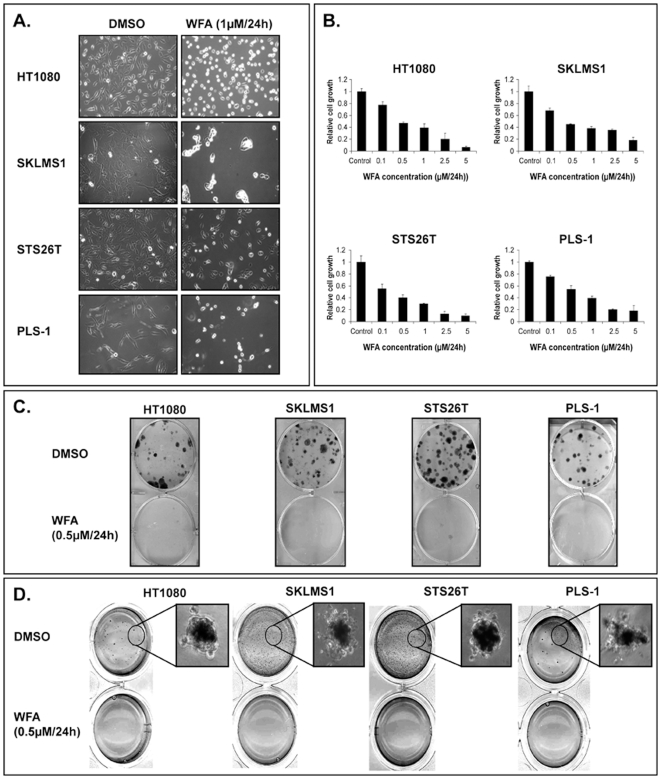
WFA inhibits STS cell growth.
A) WFA treatment (1 µM/24 h) results in marked morphological changes, including cell-rounding and nuclear condensation, in STS cells; B) MTS assays demonstrate a WFA-induced, dose-dependent decrease in STS cell growth; C) WFA (0.5 µM/24 h) markedly inhibits STS cell colony formation capacity measured after ten days; D) WFA (0.5 µM/24 h) abrogates STS cell anchorage independent growth measured after three weeks. Graphs represent the average of three repeated experiments ±SD.